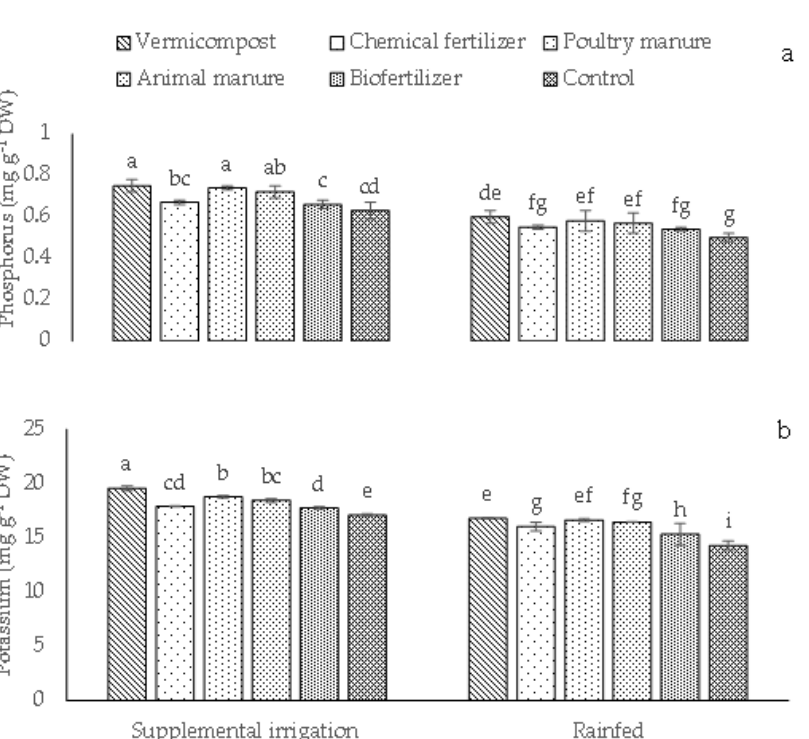
Figure 6. Means ( ± Standard deviation, SD) comparison for the interaction impacts of fertilizer and irrigation conditions on phosphorus ( a ) and potassium ( b ). DW: dry weight. The means with different letters differ significantly at p ≤ 0.05 based on Tukey’s HSD test.